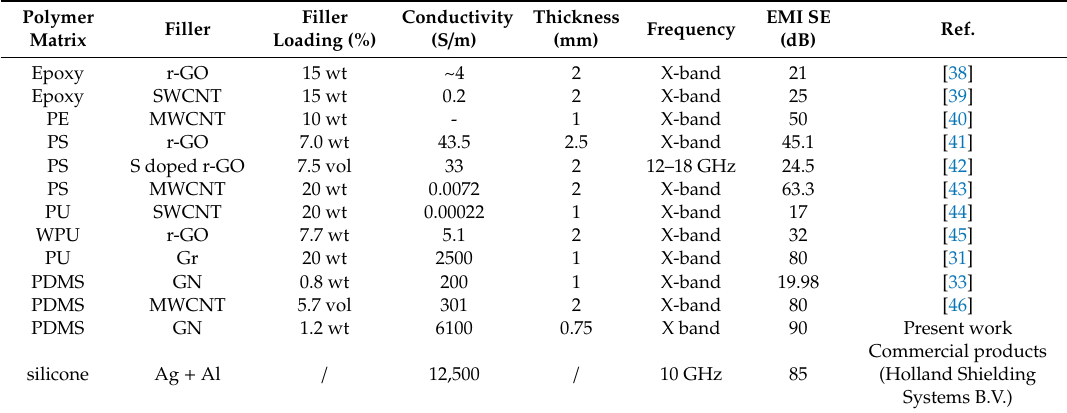
Figure 7. ( a ) Electromagnetic interference (EMI) shielding effectiveness (SE) of the PDMS/GN composite with different thickness in X‐band; ( b ) EMI SE of the 0.25 mm composite at 11.5 GHz after stretching and release cycles for 0–100 cycles. Table 1. Comparison of electrical and EMI SE properties of various CPCs. (PE: polyethylene, PU: polyurethane, SWCNT: single wall carbon nano tube, Gr: graphene).